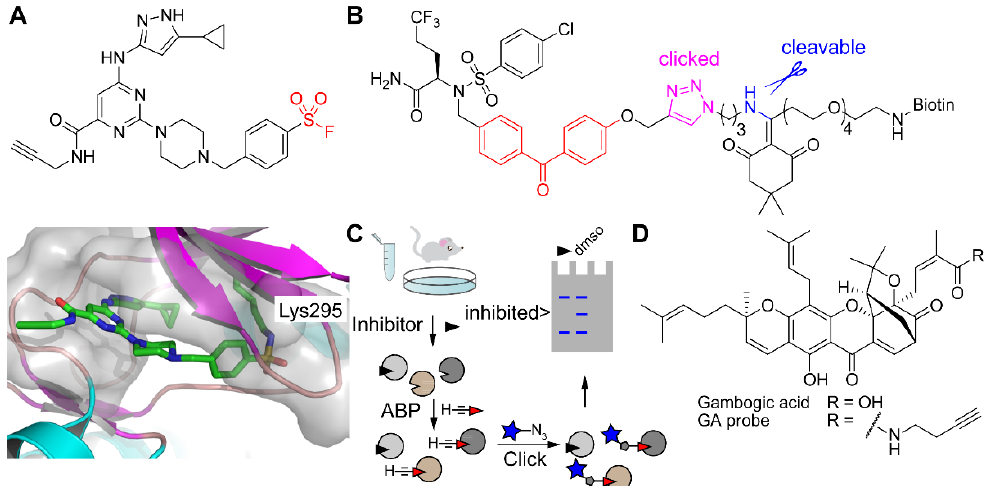
Figure 8. Detection of ABP binding sites and competitive ABPP. ( A ) Structure of a sulfonyl fluoride probe for kinases (upper; reactive group in red) and a co-crystal structure with Src kinase (lower panel) in which Lys295 has reacted with the sulfonyl fluoride. ( B ) Avagacestat-derived probe with a photoreactive group (in red), pre-clicked onto a biotin-azide reagent with an incorporated hydrazine-sensitive cleavable linker (cleavable bond in blue). ( C ) Schematic representation of competitive ABPP with click chemistry. Treatment with an inhibitor will block the active site on one or multiple targets, after which a broad-spectrum ABP is added to measure residually active enzymes. ( D ) Structure of gambogic acid (GA) and an alkyne-conjugated GA